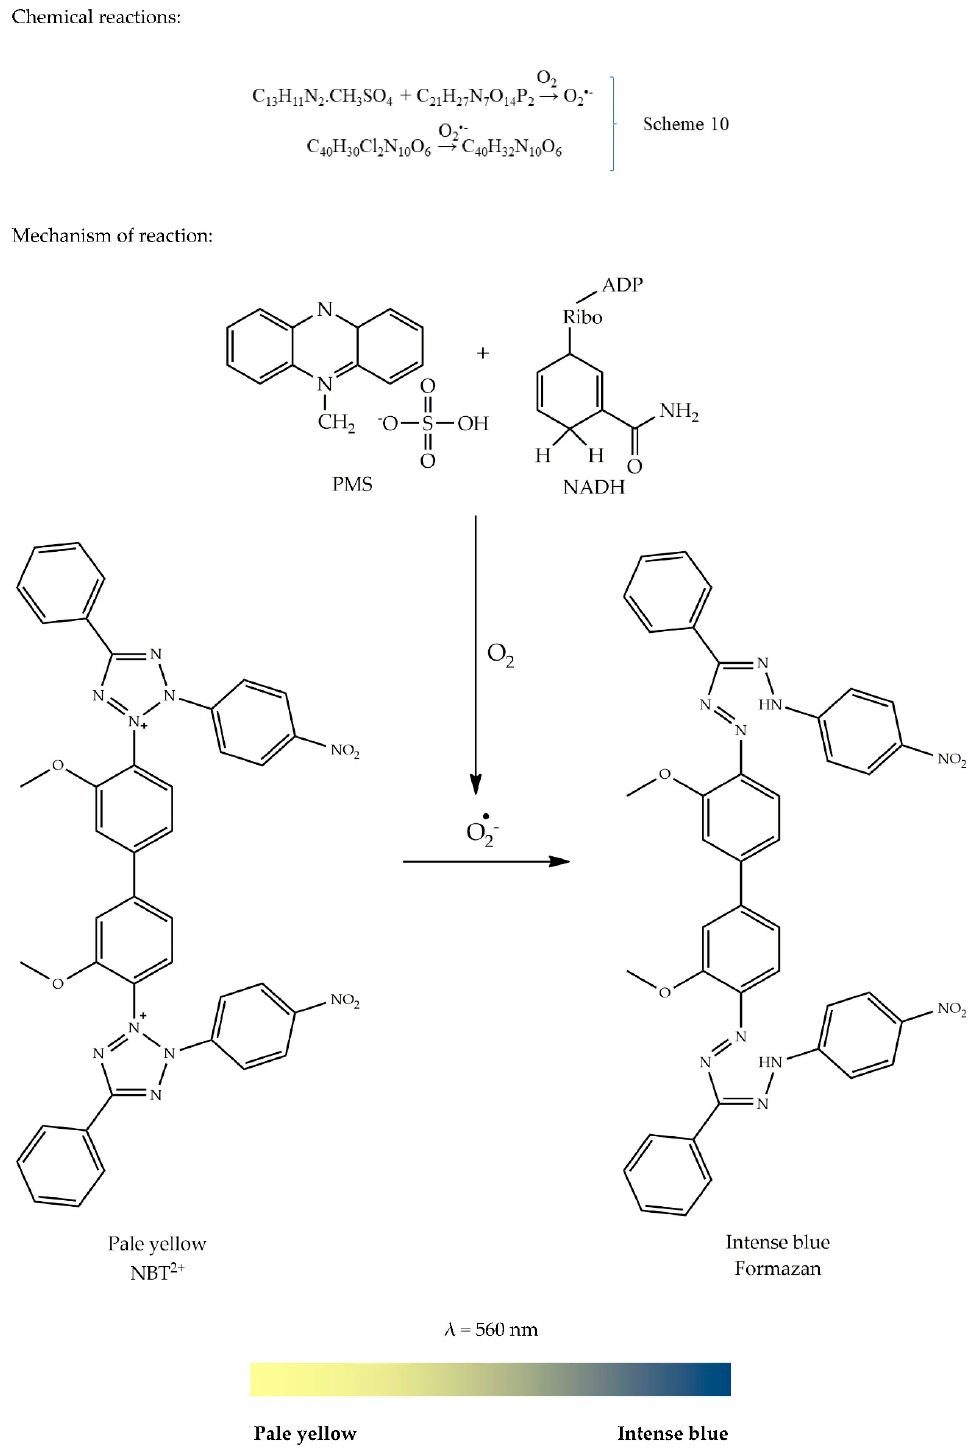
Figure 9. O 2• − reaction mechanism. Figure 9. O 2 •− reaction